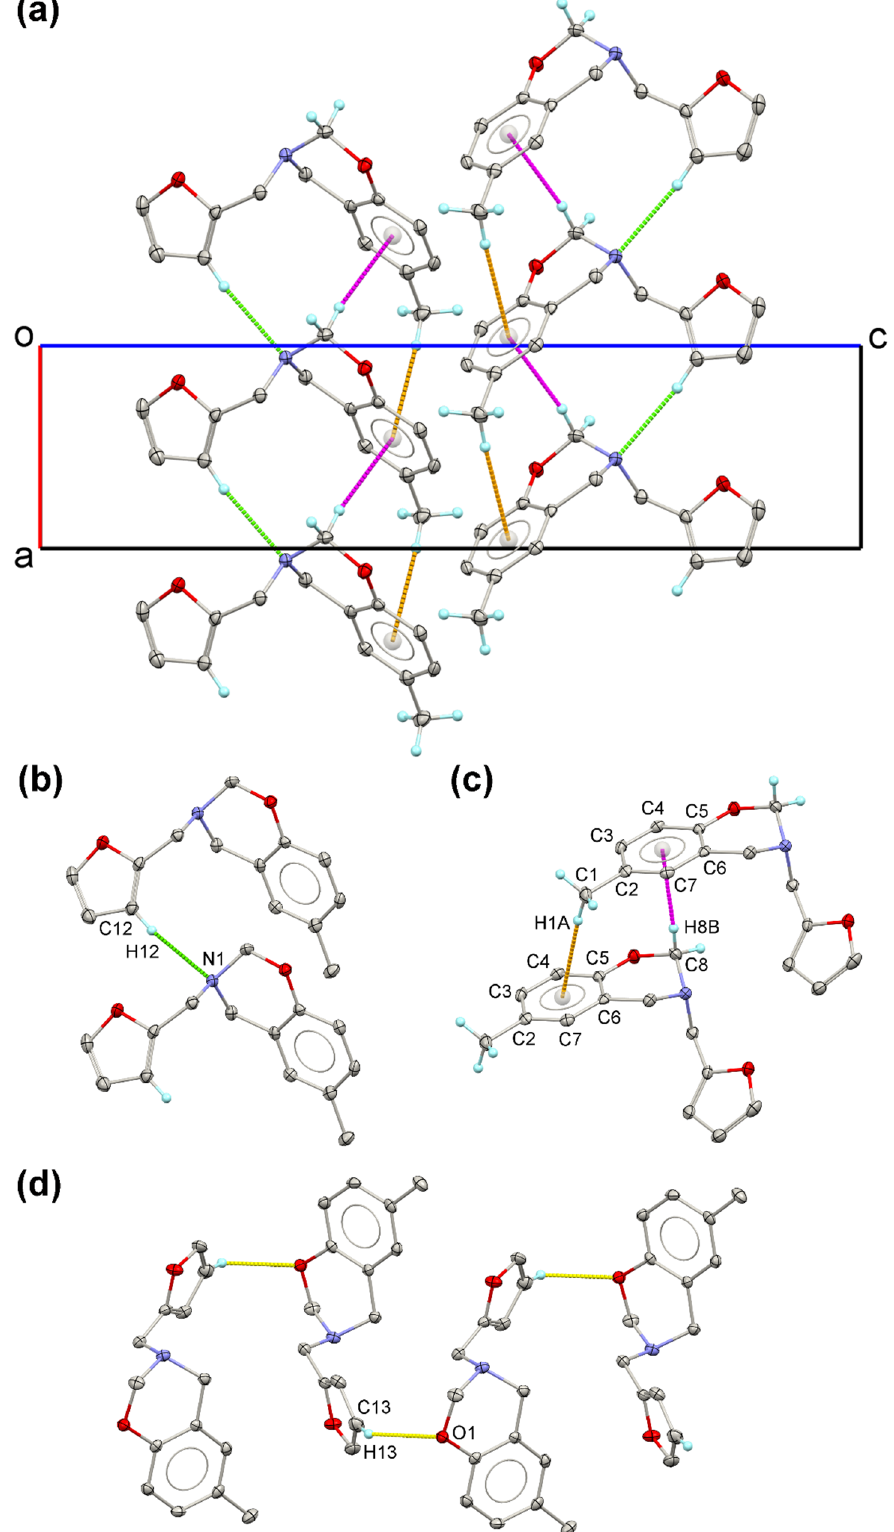
Figure 2. ( a ) A view down towards a [010] showing a part of an [100] infinite molecular chain of the C–H···N contact (green dash line) and the C–H··· π interactions (orange and magenta dash lines). A closer look at ( b ) the C12–H12 ⋅⋅⋅ N1 contact (green dash line), ( c ) the C1–H1A··· C g (orange dash line), and the C8–H8B··· C g (magenta dash line). Note that C g is the centroid of the benzene ring (C2 to C7). ( d ) The C13–H13···O1 contact shown in yellow dash line.